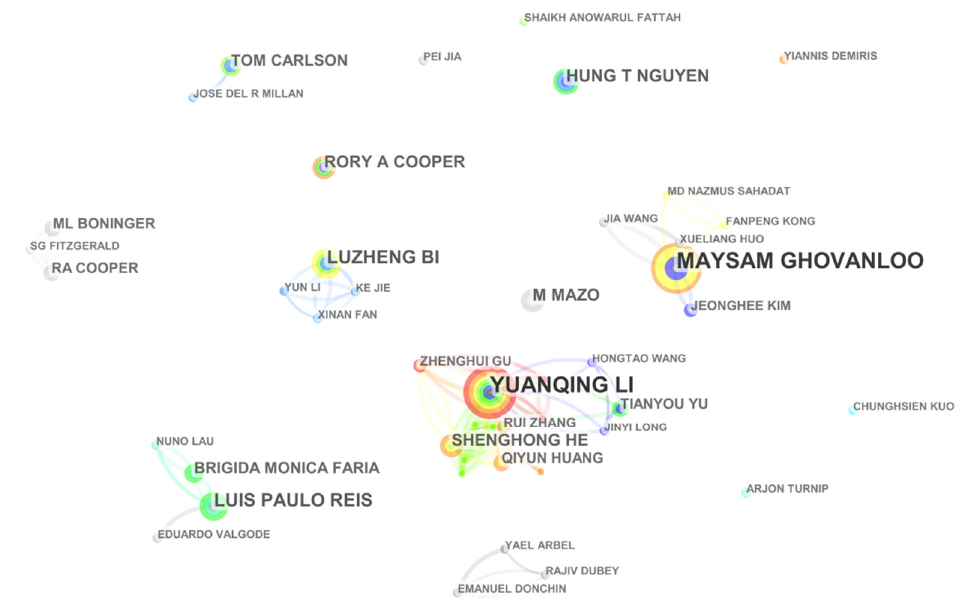
Table 5. Top 10 most productive authors involved in EPW HMI methodology research. Figure 5. A co-author map related to EPW HMI methodology research from 1998 to 2020.